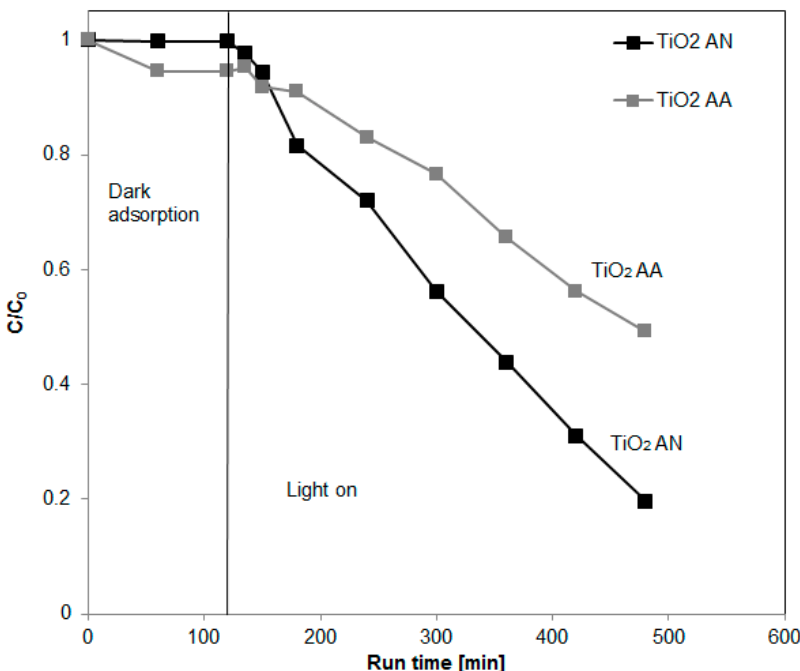
Figure 4. Photocatalytic degradation of caffeine using TiO 2 AA and TiO 2 AN under UV irradiation.